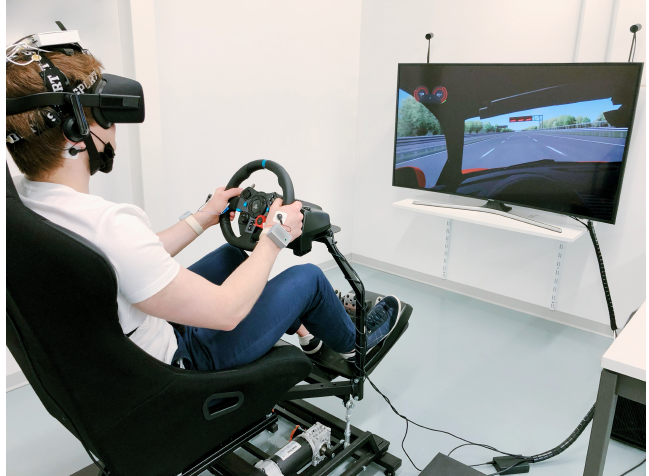
Figure 6. A test subject in our lab using our simulator setup, with SPR, ECG, and EEG sensors employed to acquire the physiological signals (Experiment 2).